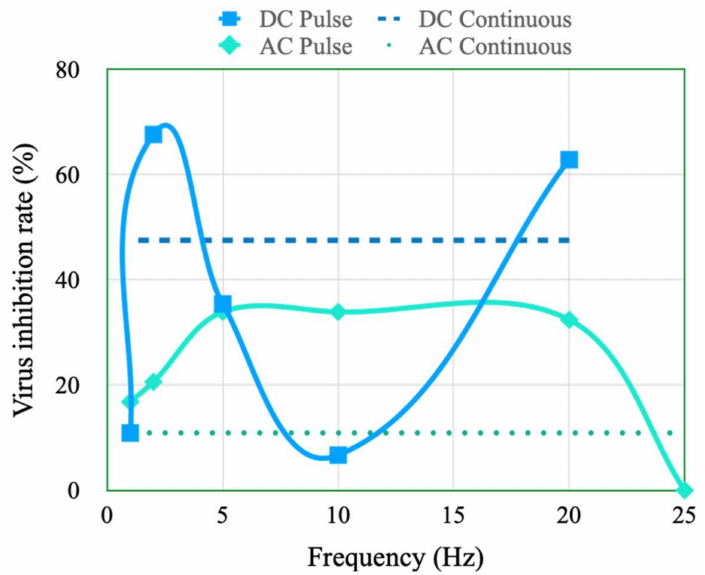
Figure 9. Viral activity-inhibition rates under DC and AC continuous and pulse stimulation conditions with different